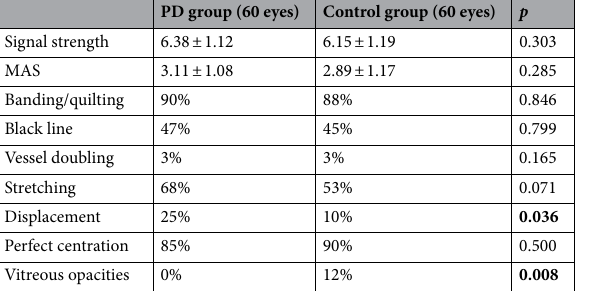
Table 2. Image quality assessment. MAS motion artifact score; Results are reported as mean ± standard deviation (range) or as percentage of affected images. p < 0.05 was considered statistically significant and bold font indicates statistical